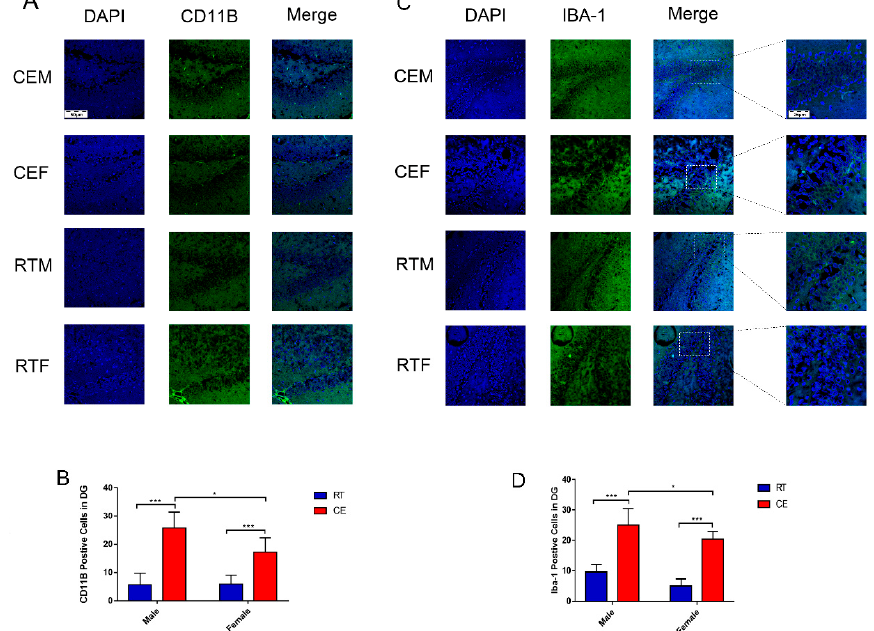
Figure 3. Immunofluorescence detection of the activated microglia marker CD11b and IBA-1 in the dentate gyrus (DG) of cold-stressed mice. ( A ) CD11b-positive cells (green) were counterstained with 4’,6-diamidino-2-phenylindole (blue). Scale bar = 50 µ m. ( B ) Quantification of CD11b-positive cells in the DG. ( C ) IBA-positive cells (green) were counterstained with 4’,6-diamidino-2-phenylindole (blue). Scale bar = 50 or 25 µ m. ( D ) Quantification of IBA-1-positive cells in the DG. Differences between room temperature male (RTM) and cold exposure male (CEM), room temperature female (RTF) and cold exposure female (CEF), and CEM and CEF groups were evaluated by two-way analysis of variance. Results are expressed as the mean ± SD ( n = 6) of four independent experiments. * p < 0.05, *** p < 0.001.